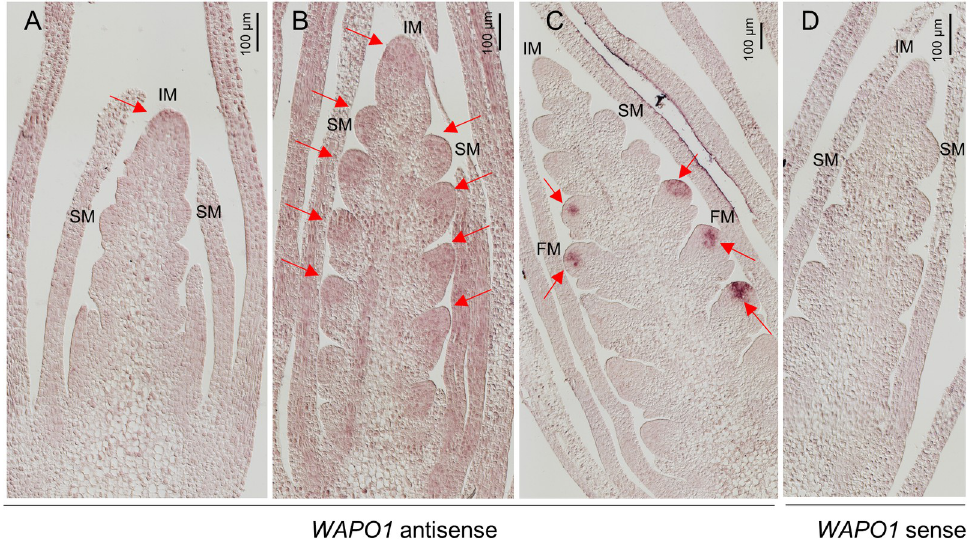
Fig 6. In situ hybridization analysis of WAPO-A1 in sections of developing spikes of tetraploid wheat Kronos. ( A - C ) WAPO1 antisense probe. ( D ) WAPO1 sense probe used as a negative control in a developing spike at W2.5 with undifferentiated spikelet meristems (SM). ( A ) Developing spike at the double ridge stage (W2.5). ( B ) Early spike development with undifferentiated spikelet meristems (W3.0). Weak WAPO1 expression was detected in the inflorescence meristem and spikelet meristem. ( C ) Spikes at W3.25-W3.5 showing strong expression of WAPO1 in the incipient floret meristems of the more developed spikelets closer to the center of the spike. W values indicate developmental stages based on the Waddington scale. IM = inflorescence meristem, SM = spikelet meristem, and FM = floret meristem. Red arrows indicate WAPO-A1 hybridization